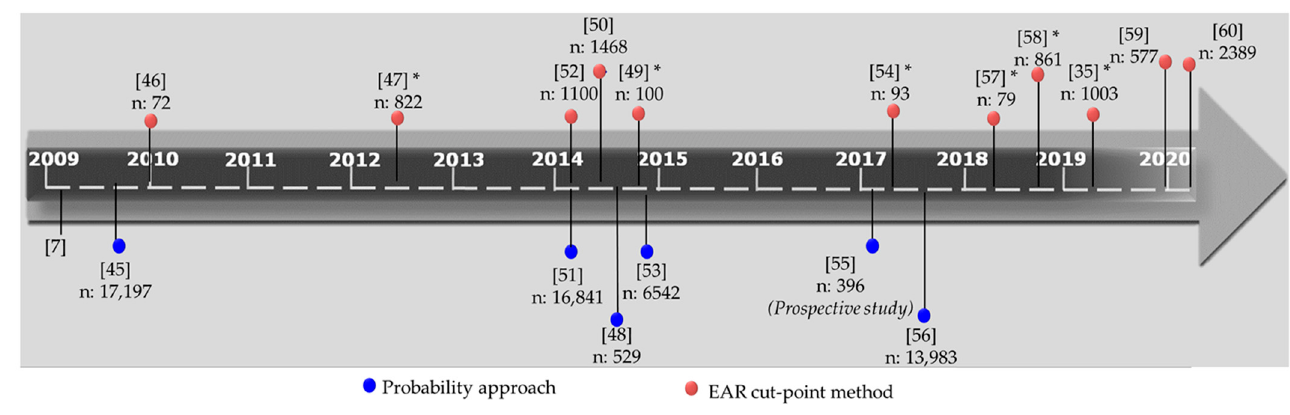
Figure 6. Timeline of selected studies that have applied the probability approach and the EAR cut-point method, since